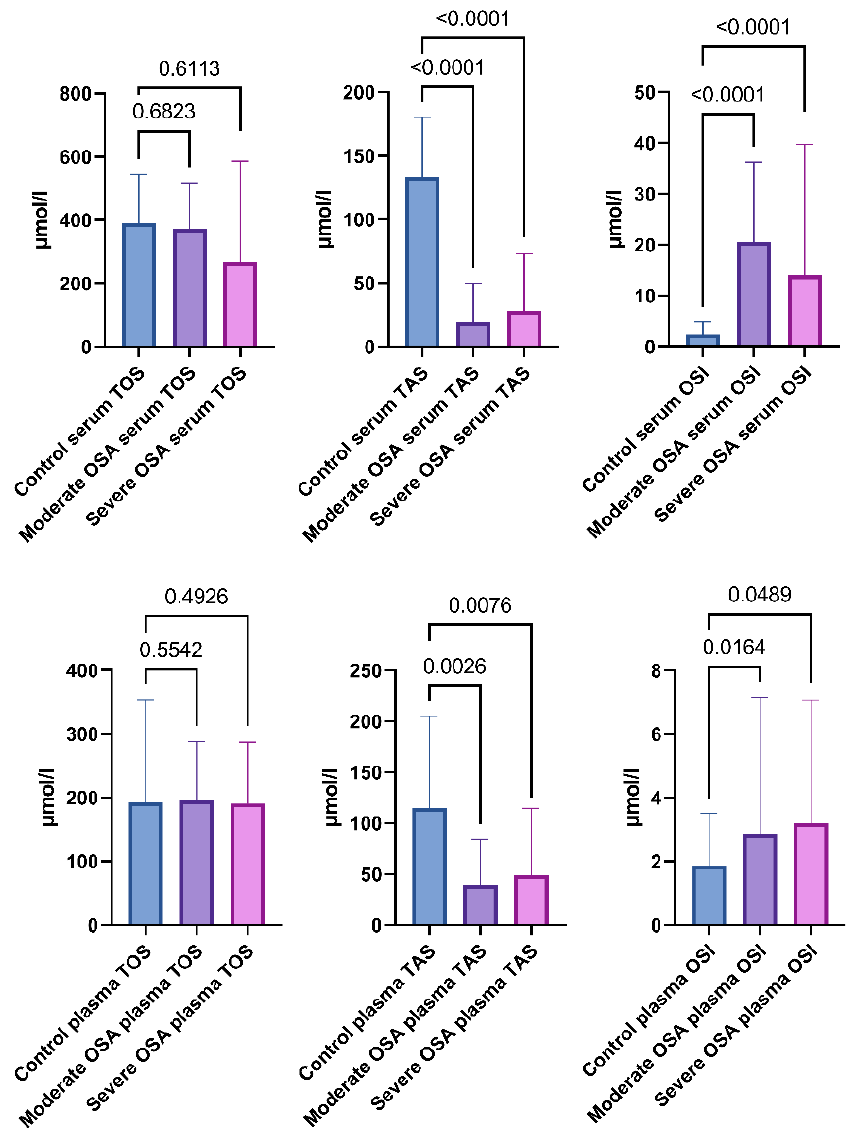
Figure 5. Total Oxidative Status (TOS), Total Antioxidative Status (TAS), and Oxidative Stress Index (OSI) of the serum and plasma of the participants from the Moderate OSA group, Severe OSA group, and control group. Data represent the median and interquartile range and p -value of the OSA group vs. the control group. Table 5. Mutual dependences between the investigated parameters.